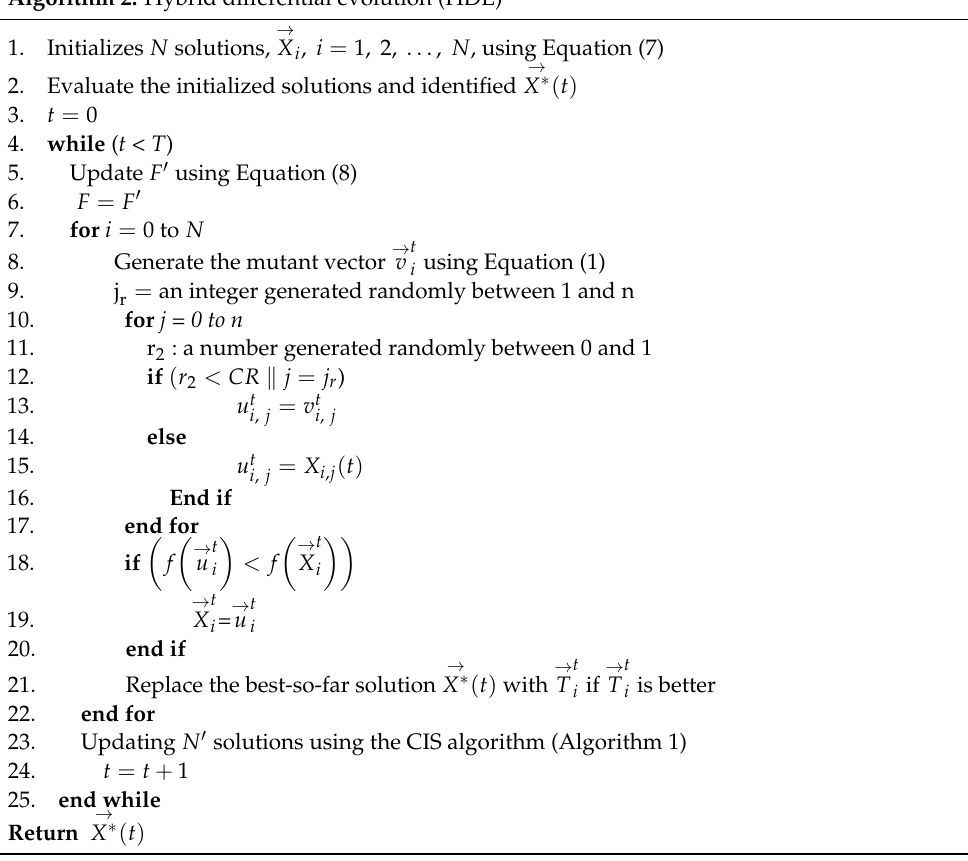
Algorithm 2. Hybrid differential evolution